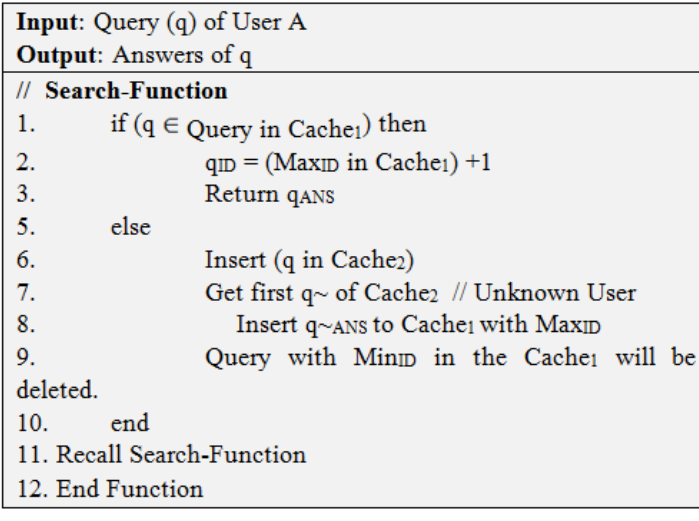
Figure 14. Algorithm 2 of